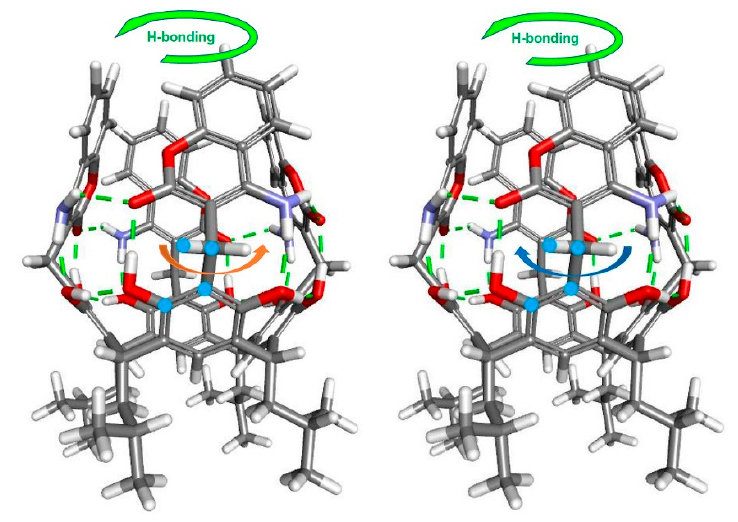
Figure 6. The structure of derivative 3 with the hydrogen bonding system direction (green arrow) and the direction of the marked dihedral angle: left —orange arrow, right —blue arrow. Int. J. Mol. Sci. 2020 , 21 , x FOR PEER REVIEW